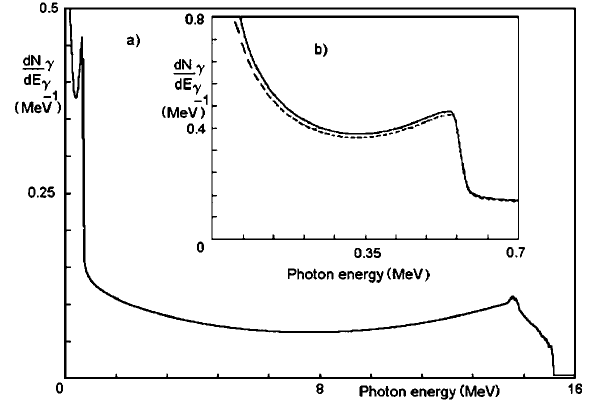
FIG. 7. The expected photon spectrum for 3 GeV positrons in the range 0–16 MeV (a) and 0–0.7 Mev (b). The dashed curve and the normalization are as in Fig.